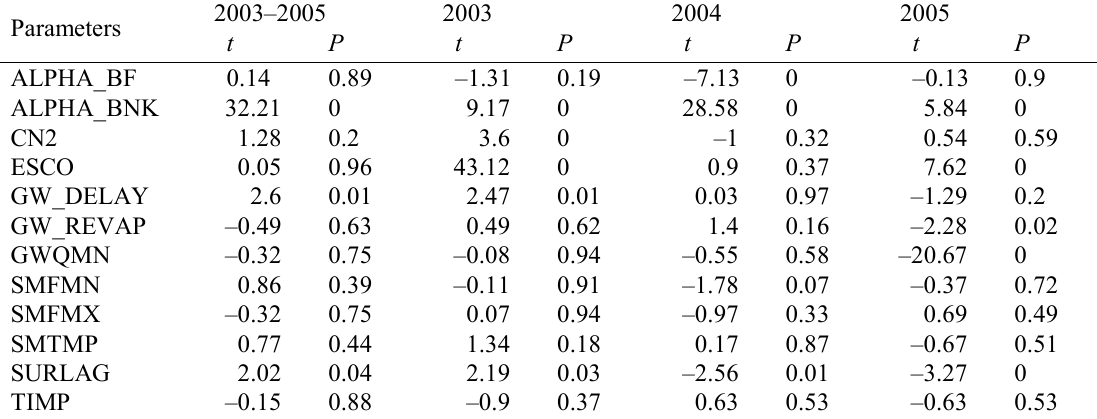
Table 3 Results of parameter sensitivity analysis for the four data